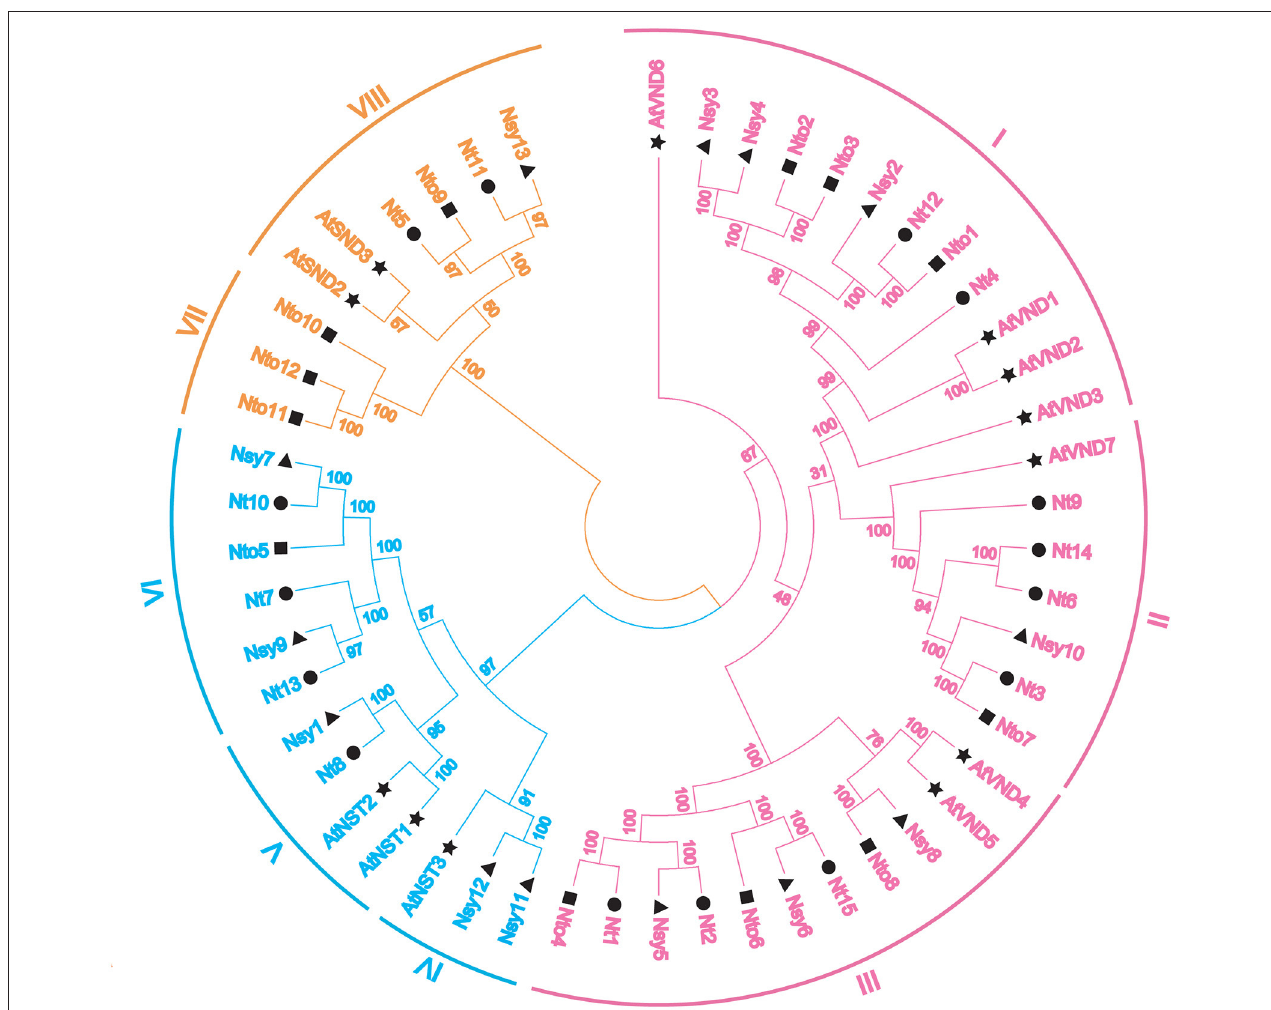
FIGURE 1 | Phylogenetic tree of secondary wall-associated NAC genes (SWNs) with Arabidopsis thaliana , Nicotiana tomentosiformis , Nicotiana sylvestris , and Nicotiana tabacum . Fifty-two SWN proteins were classed into three groups, which are highlighted in specific colors: vascular-related NAC domain genes (VNDs) in pink, NAC secondary wall thickening promoting factor genes (NSTs) in blue, and secondary wall-associated NAC domain genes (SNDs) in orange. Black graphic symbols represent different species: stars indicate A. thaliana , triangles indicate N. Sylvestris , squares indicate N. tomentosiformis, and circles indicate N. tabacum . Peripheral arcs indicated the subgroups of each group, and Roman numerals on the arc represent the subgroups of each